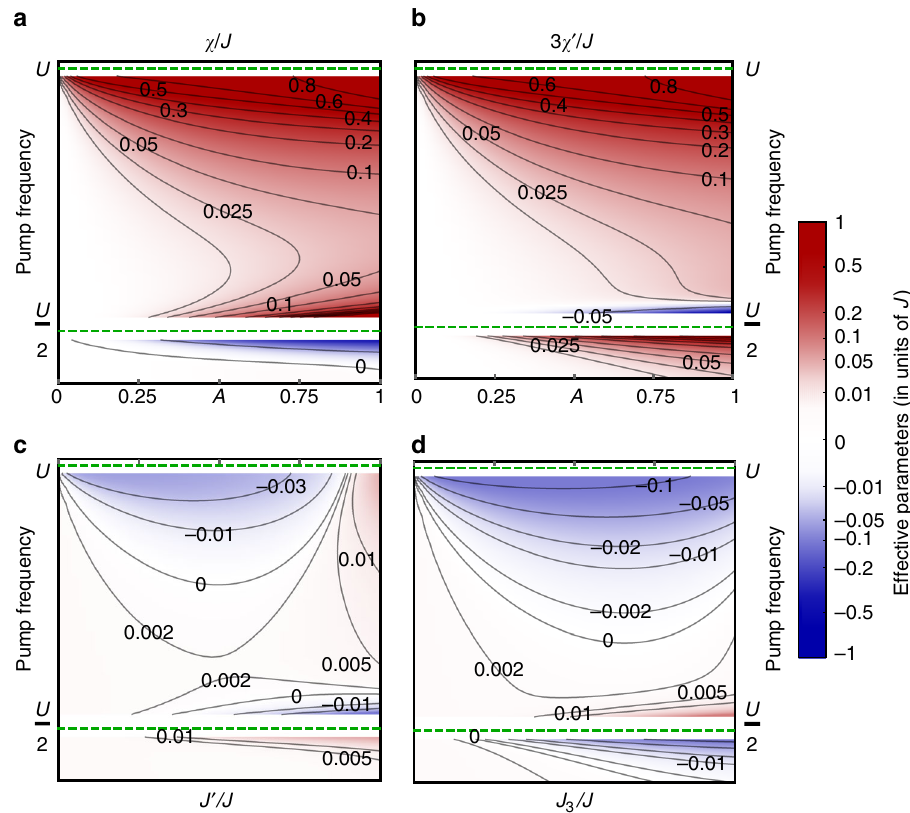
Fig. 2 Pump dependence of chiral spin model parameters. Photo-induced time-reversal symmetry (TRS) breaking scalar spin chirality χ , χ ′ ( a , b ) and TRS preserving Heisenberg exchange J ′ , J 3 ( c , d ) terms for a Kagome Mott insulator pumped by circularly polarized light, as a function of pump strength A and pump frequency (from Eqs. (4) – (10)). Parameters are depicted in units of nearest-neighbor exchange coupling J . Dashed lines indicate one- and two-photon resonances with respect to the Hubbard repulsion U . Equal signs of χ , χ ′ signify a staggering of S i · ( S j × S k ) contributions between elementary triangles and isosceles triangles inside the